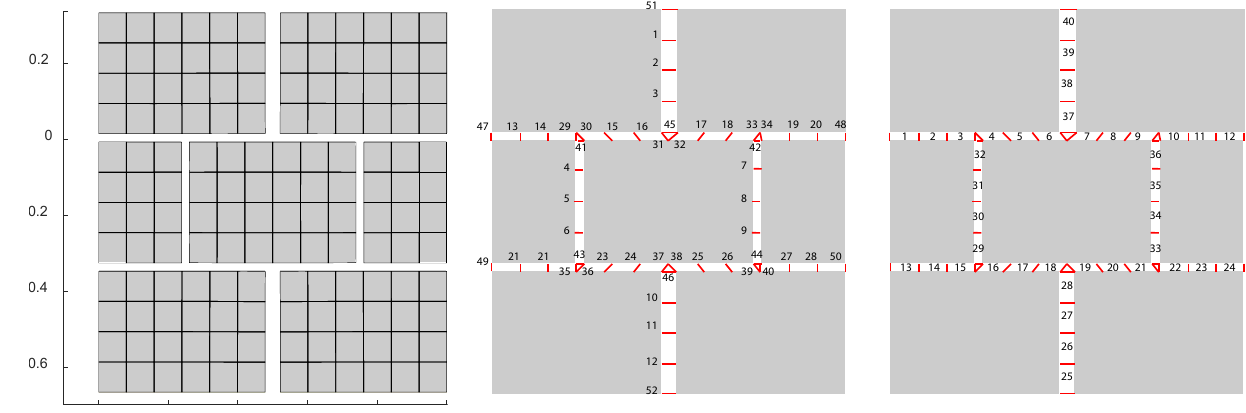
Figure 2. Geometry of the micro-scale configuration Finite Element Mesh, matrix elements with unit cell adimensional axes ( left ), crack network links ( center ) and crack network elements ( right ). Cracks are totally closed in the initial configuration, figure shows cracks with opening for convenience of representation.